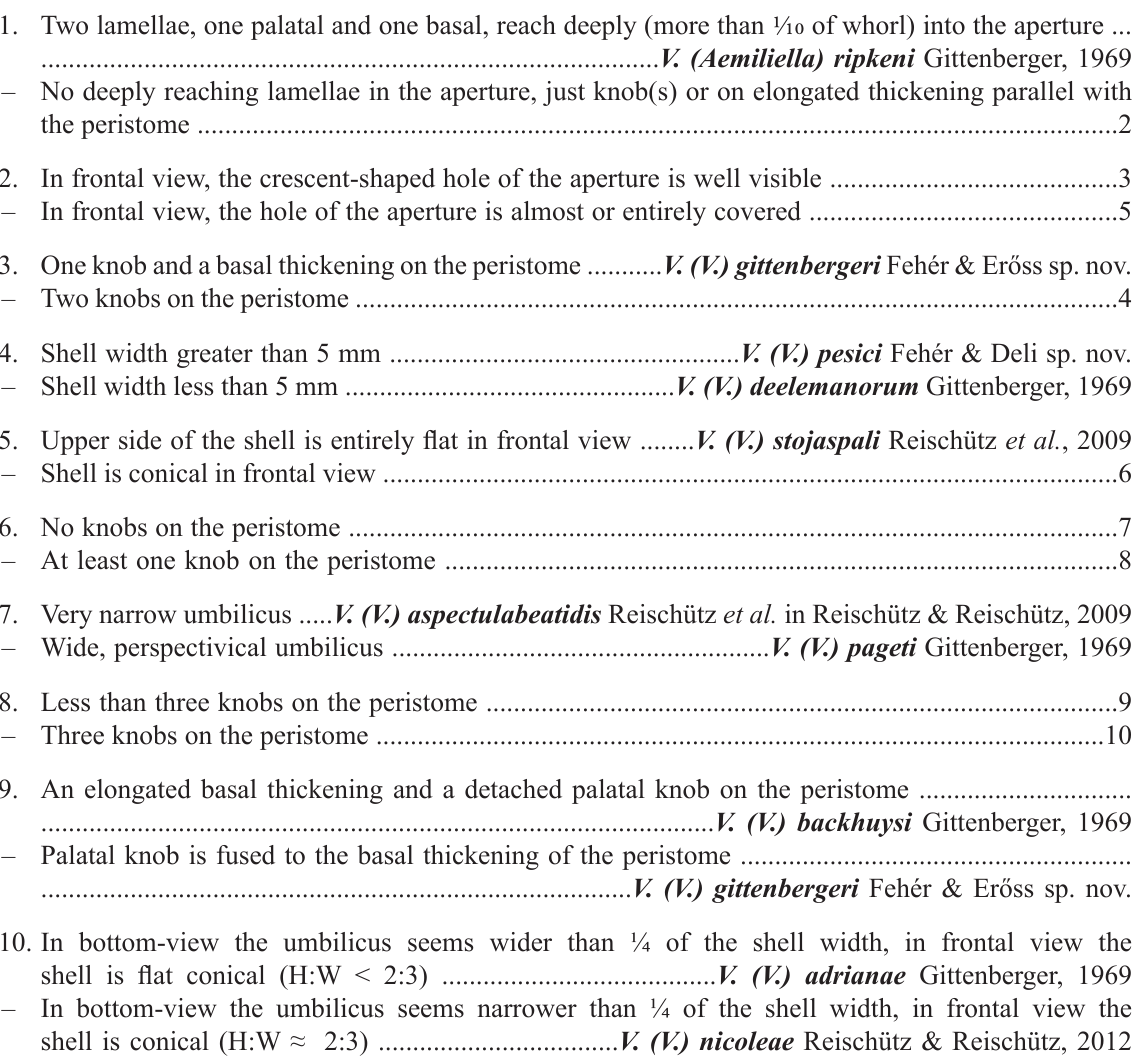
fig. Diagnosis Discoid, shouldered shell, barely raised spire, wide umbilicus. Aperture crescent-shaped, most of it but the sinus region covered by a parietal flap in frontal view. Three wide knobs at basal–palatal peristome. Material examined